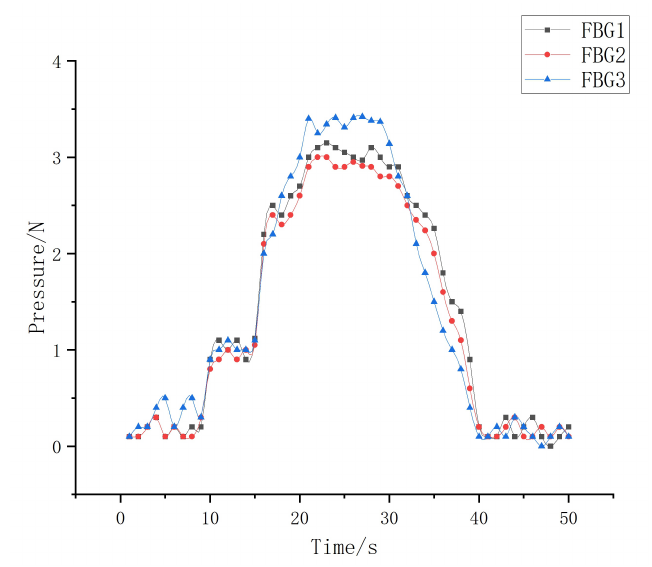
Figure 29. Pressure change diagram of three sensors.